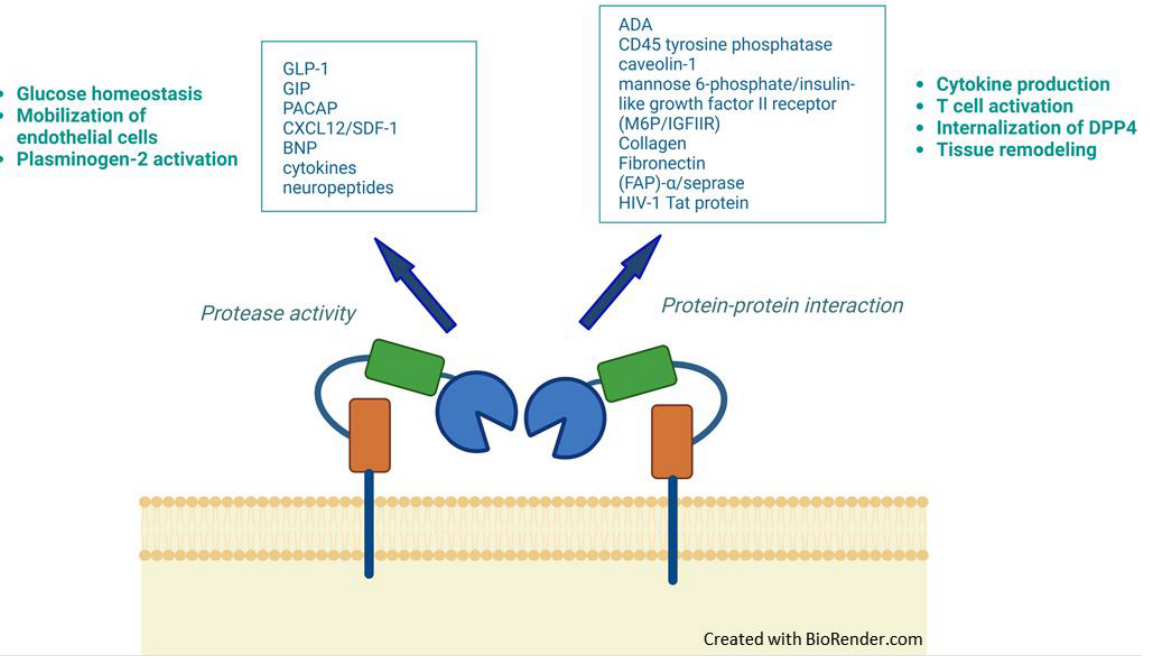
Figure 2. Schematic representation of DPP4 functions through its protease activity (on the left ) or its own structure (on the right ). Within the boxes, ligands or interacting partners of DPP4 are indicated, while the physiological processes in which they are involved are noted outside.